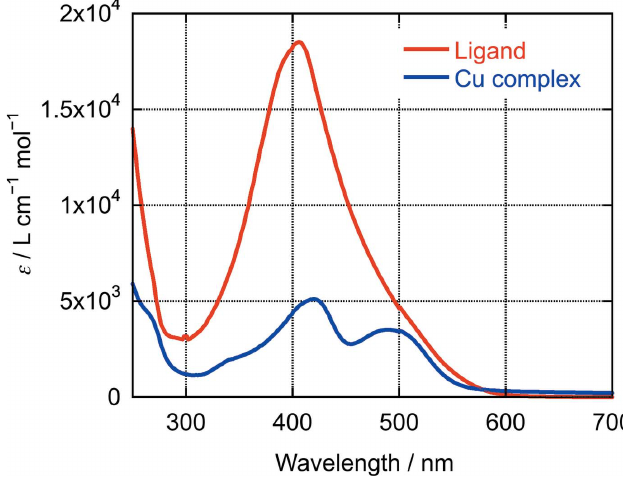
Figure 4 UV–Vis spectra of the ligand and the title compound in CH 3 CN.